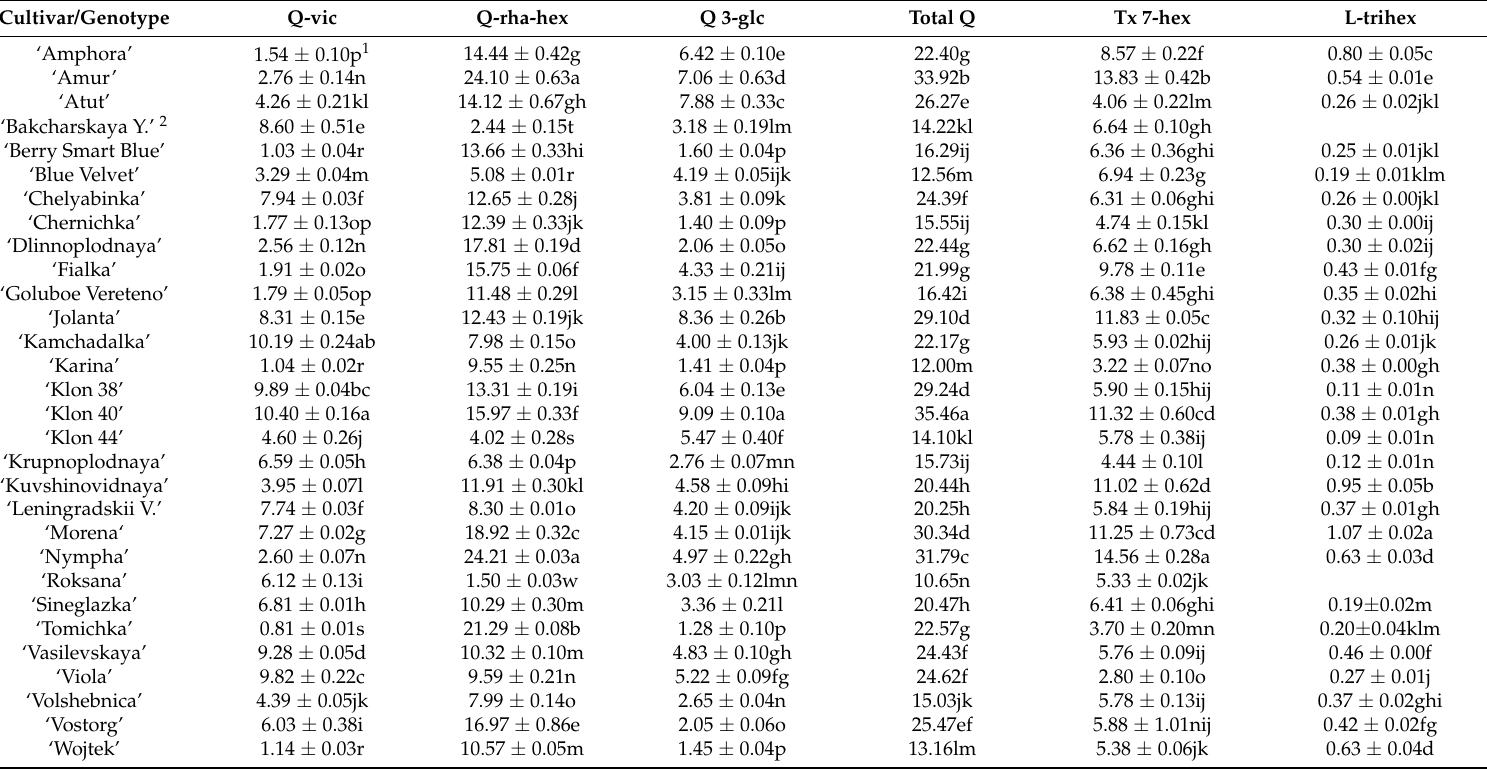
Table 4. Flavonol, flavanonol, and flavanone contents (mg/100 g fw) of different blue honeysuckle cultivars and